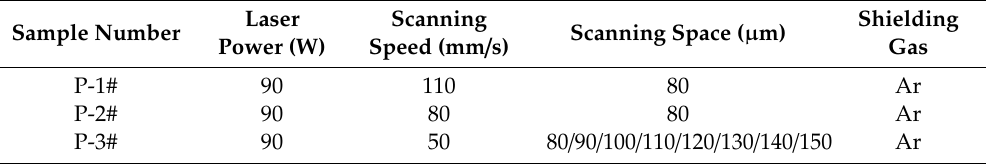
Table 2. Laser remelting process parameters.